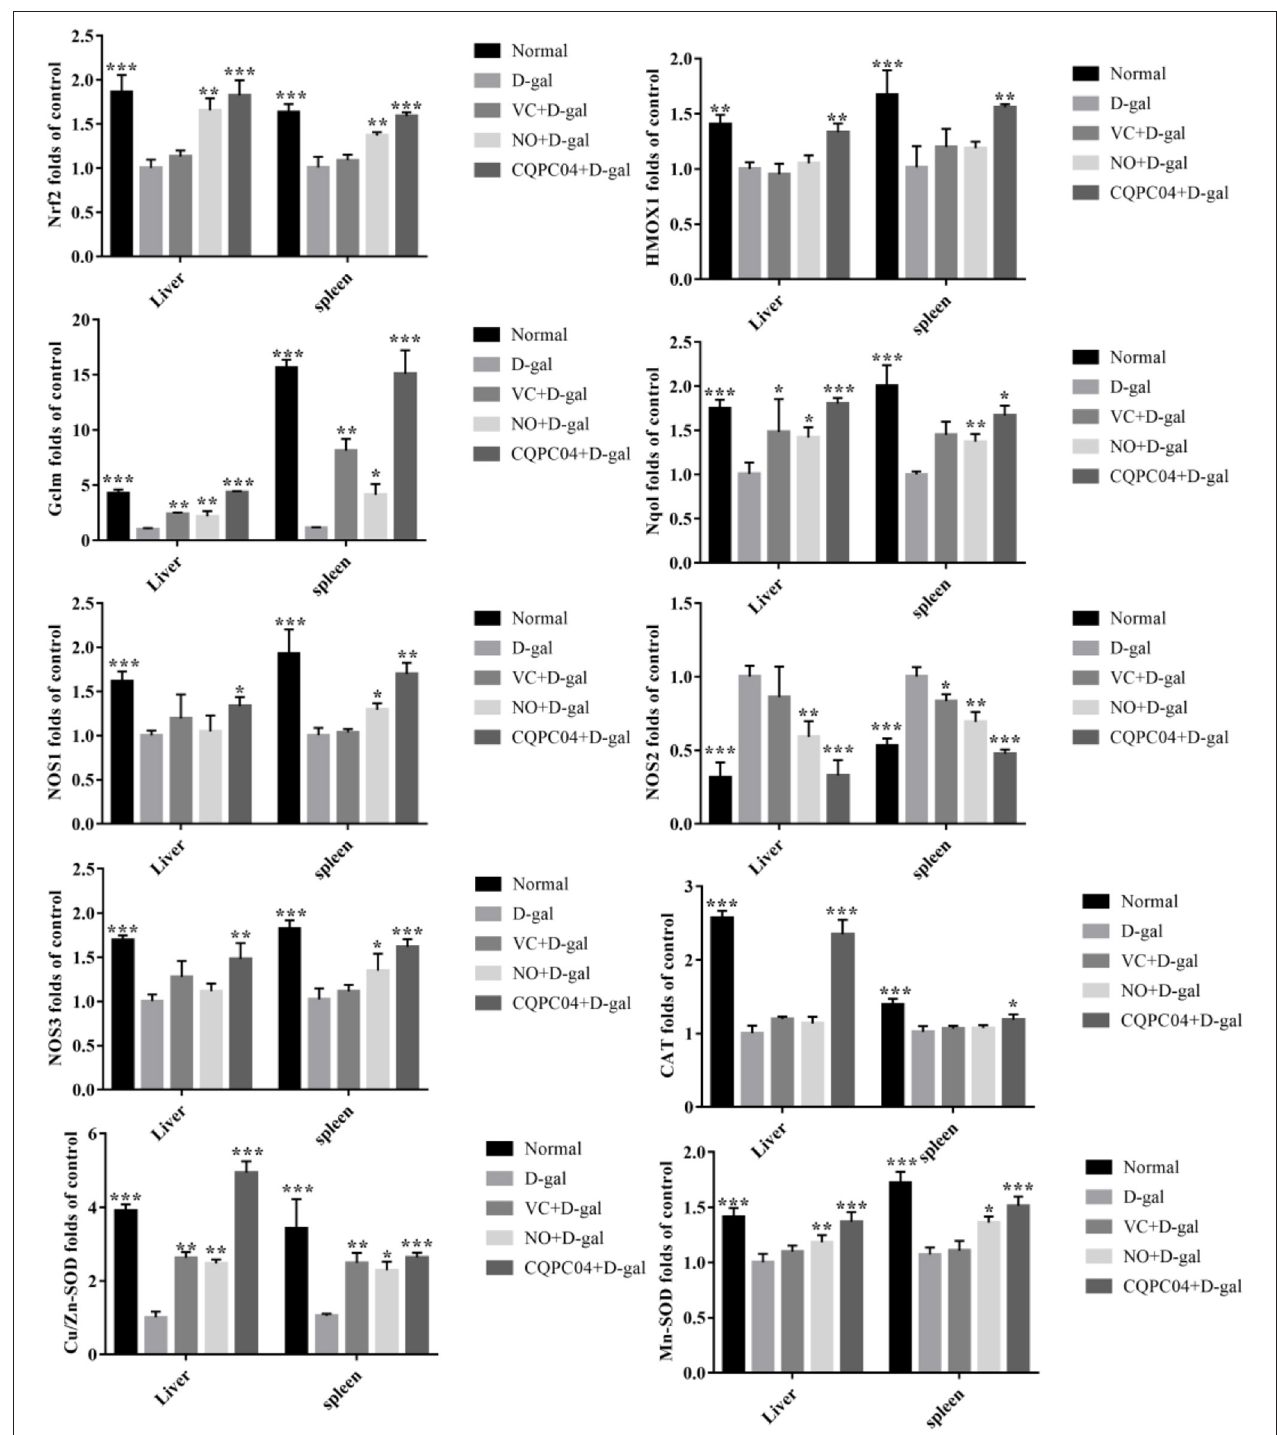
FIGURE 6 | mRNA expression of Nrf2, HMOX1, Nqol, Gclm, NOS1, NOS2, NOS3, CAT, Cu/Zn-SOD, and Mn-SOD in the liver and spleen. D-gal: mice fed the standard chow diet plus drinking water with intraperitoneal injection of D-galactose (120 mg/kg of BW); D-gal + VC: vitamin C (100 mg/kg of BW) plus intraperitoneal injection of D-galactose (120 mg/kg of BW); D-gal + NO: non-fermented soy milk (0.1 mL/10g of BW) plus intraperitoneal injection of D-galactose (120 mg/kg of BW); D-gal + CQPC04: L. fermentum CQPC04-fermented soy milk (0.1 mL/10g of BW) plus intraperitoneal injection of D-galactose (120 mg/kg of BW). * p < 0.05, ** p < 0.01, and *** p < 0.001 compared to D-gal